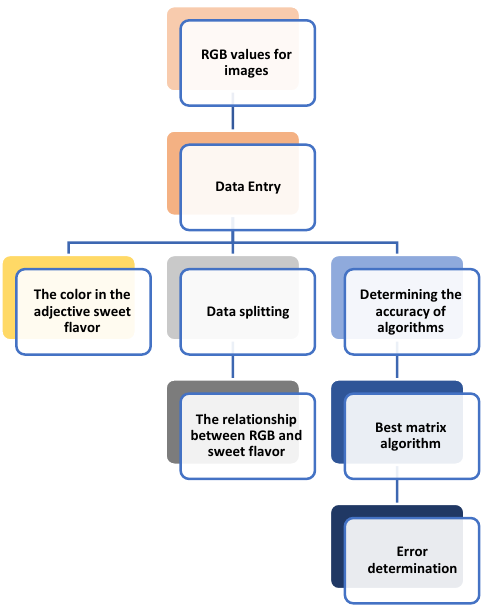
Figure 1. Diagram of the sweetness prediction methodology.